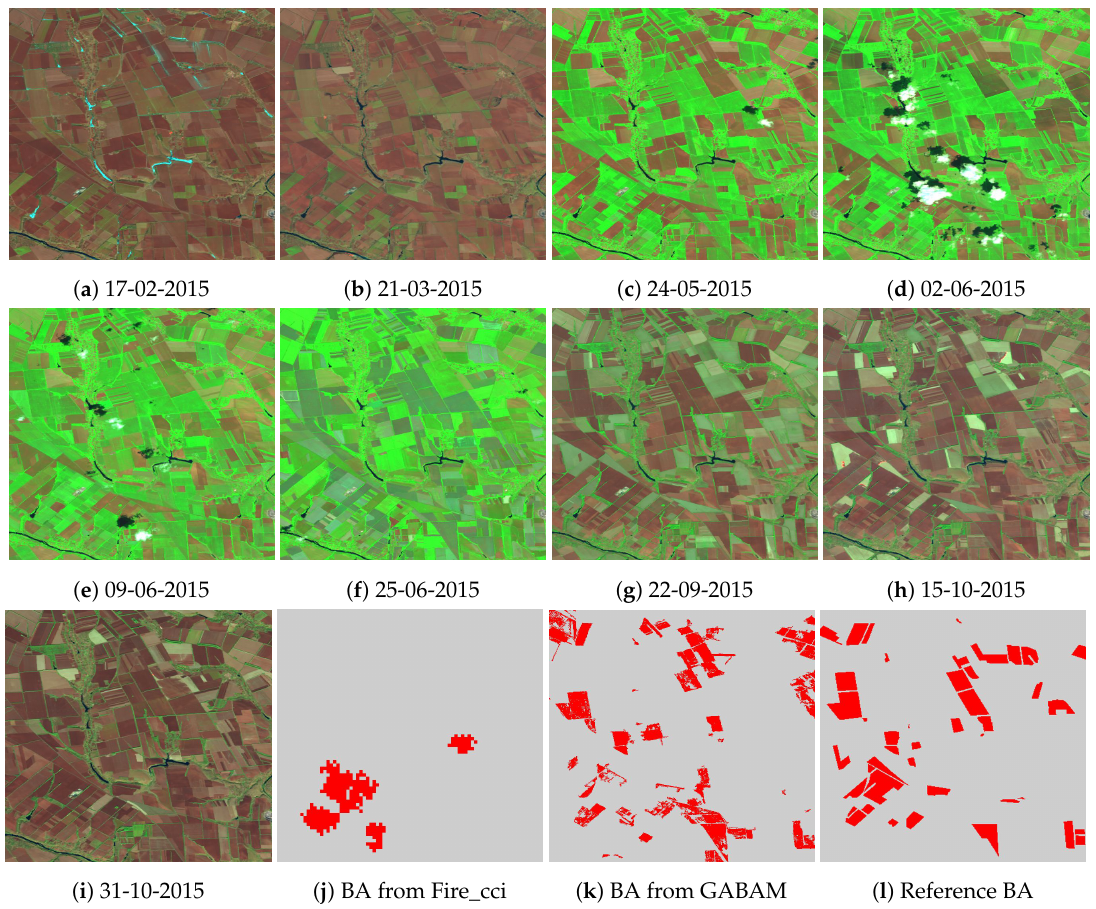
Figure 10. Burned area map example of croplands in Mykolayiv, Ukraine. ( a – i ) show the Landsat-8 images displayed in false color composition (red: SWIR2 band, green: NIR band, and blue: green band); ( j – l ) show the BA from Fire_cci product, GABAM 2015, and reference BA,